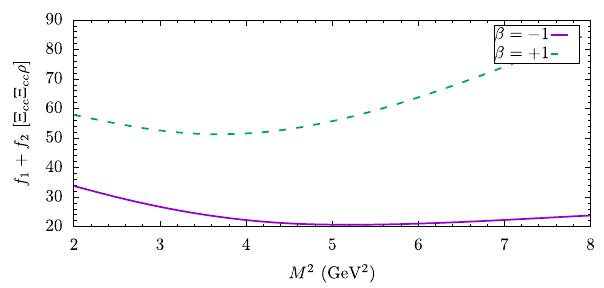
Fig. 5 The dependence of the coupling constant f 1 + f 2 for Ξ (cid:7) on cos θ for the shown values of M 2 and at